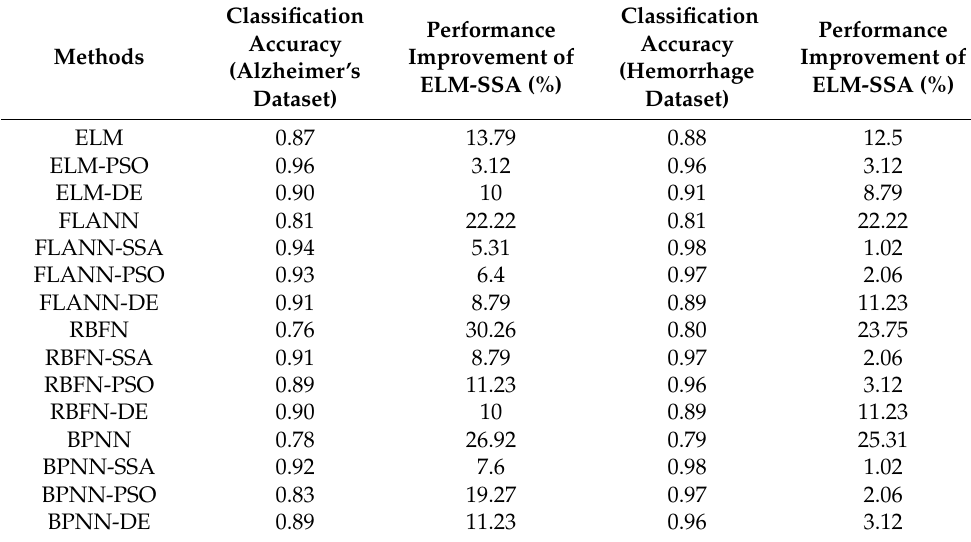
Table 6. Performance comparison of ELM-SSA model with other classification models.